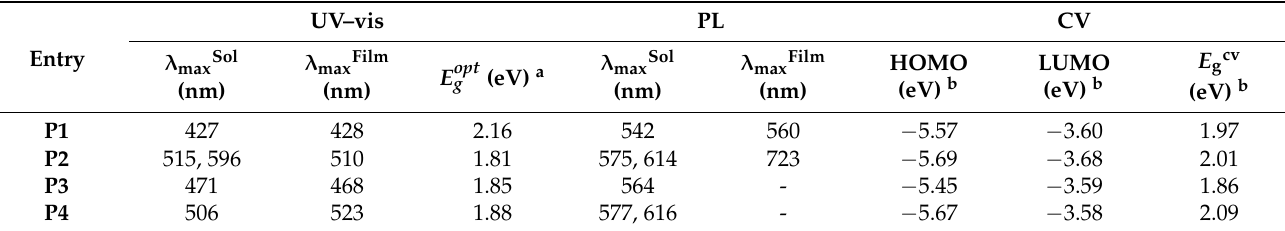
Figure 3. Normalized absorption spectra of P1 – P4 ( a ) in dilute chloroform solution (1 × 10 − 5 mol/L) and ( b ) in the thin film state (spin-cast from chloroform solution). Table 2. Photophysical and electrochemical properties of P1 – P4 .